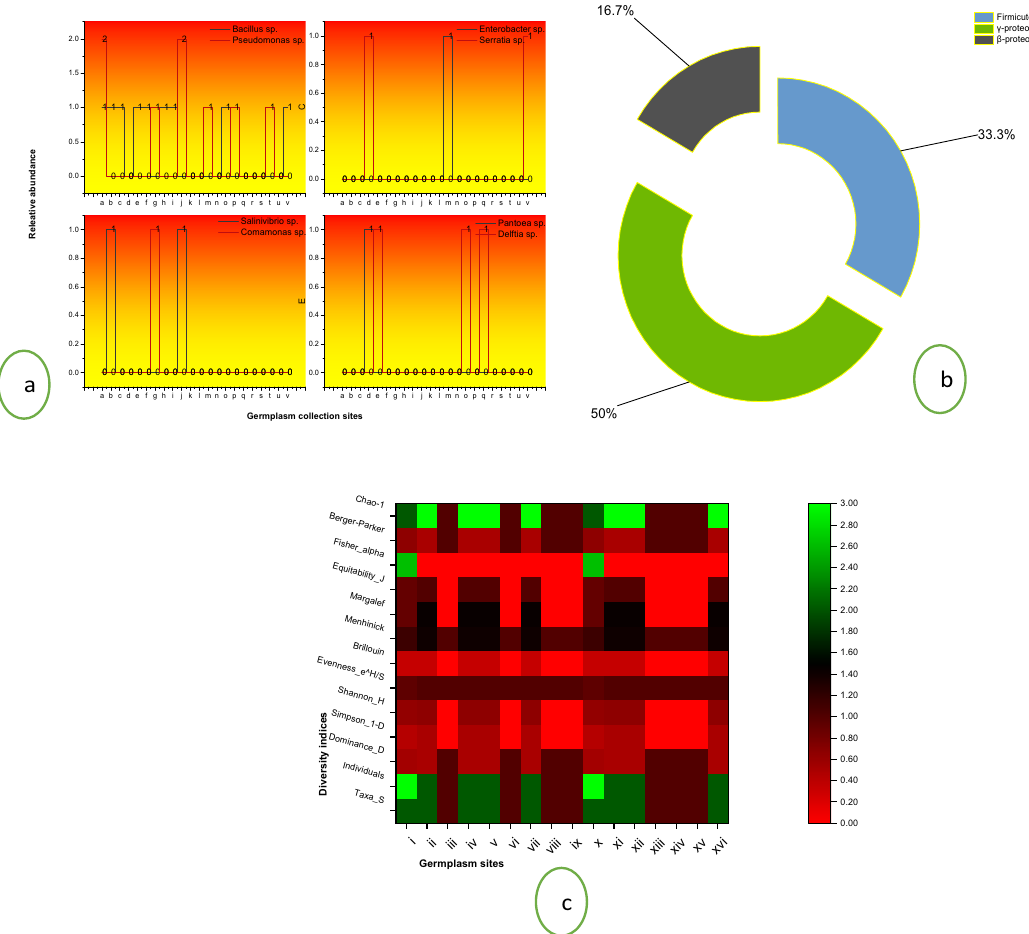
Figure 3. Relative proportion of chitinase producing bacterial endosymbiosiome associated with B. rapa L.; (a) genus level; ( b ) taxonomic classes and ( c ) Diversity indices of bacterial endosymbiosiome of B. rapa L. from different sampling sites, where symbols: (i) Akura; (ii) Bona Nambal; (iii) Hugam; (iv) Hutmara; (v) Panzmulla; (vi) Rakh Chandipora; (vii) Tujar; (viii) Bomai; (ix) Brath; (x) Juhama; (xi) Nowgam; (xii) Rangreth; (xiii) Khunmoah; (xiv) Zakura; (xv) Dhara; and (xvi) strains, and their 16S rRNA gene sequence data are presented in (Table 2). Based on 16S rRNA gene sequences of the chitinase-producing microflora, the details of their closest neighbor are given in Table 3. Chitinase production. Based on their ability to produce chitinase, the top ten isolates were further stud- ied to make chitinase when augmented with various carbon sources (maltose, glycerol, glucose, and sucrose) supplementations under different incubation periods (Fig. 4b). The average chitinase activity was significantly highest in glycerol supplementation, followed by glucose. The minor chitinase activity was observed in maltose. The incubation period greatly influenced chitinase activity, with the average highest chitinase activity at 192 h followed by 240-h incubation (Fig. 4c). With the increase in the incubation period, there was a corresponding increase in chitinase activity, and maximum activity was observed at the 192-h incubation period, beyond which a decline was noticed. The significantly most minor average chitinase activity among all the incubations was honored at the incubation period of 48 h, and all the isolates followed this trend. The chitinase production by all the isolates increased significantly with the incubation period from 48 to 192 h; there was a decrease beyond 192 h incubation. Indole‑3‑acetic acid and other plant growth associated metabolite production. Among all the strains, only eleven produced IAA, and the highest production was observed in smppsap6 (16.55 µg/mL) and the lowest (3.13 mg/mL) in skuast2 strain (Table 4). A total of ten strains were able to solubilize tricalcium phos- phate varying from 3.07 to 9.04 mm; the solubilization index ranged from 1.24 in strain SKUAST-K11 to 2.53 in strain SKUAST-K43. The phosphorus released expressed as mg/L varied from 38.23 in strain SKUAST-K67 to 264.80 mg/L in strain SKUAST-K46. The siderophore production expressed as percent unit was produced by eight strains and varied from 9.93 in strain SKUAST-K35 to 18.83 in smppsap4 strain. The HCN production described as absorbance (λ 625 nm) was created by seven strains and ranged from 0.012 in strain SKUAST-K46 to